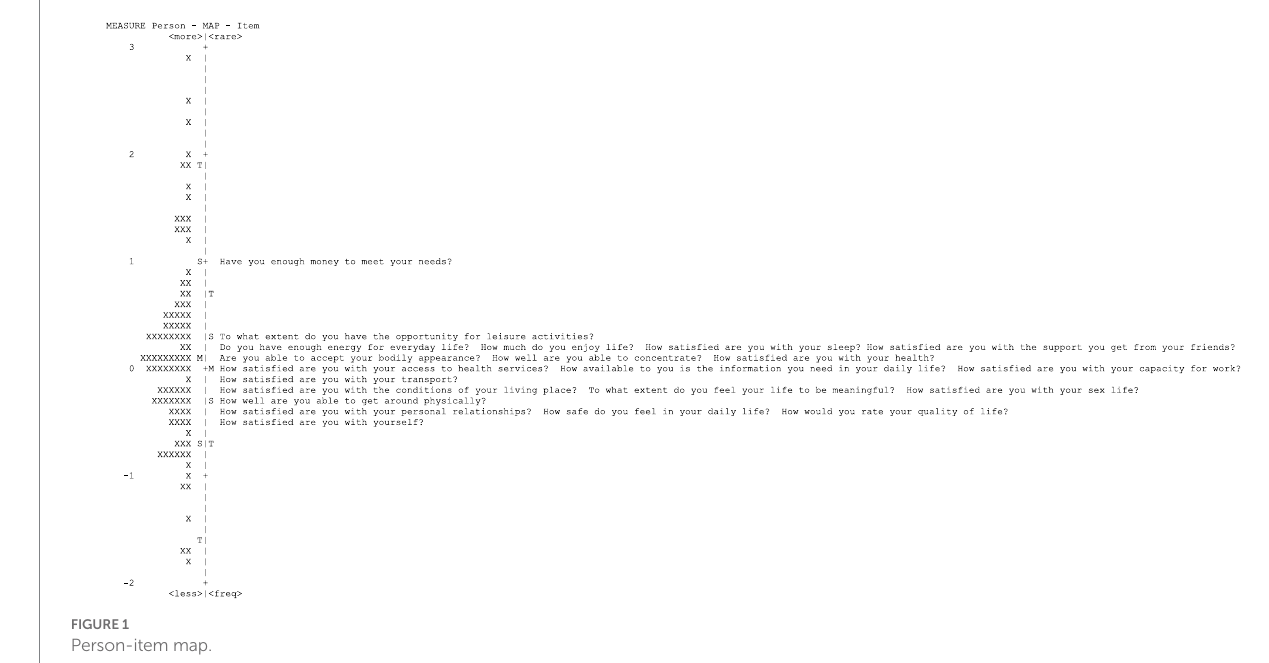
FIGURE 1 Person-item